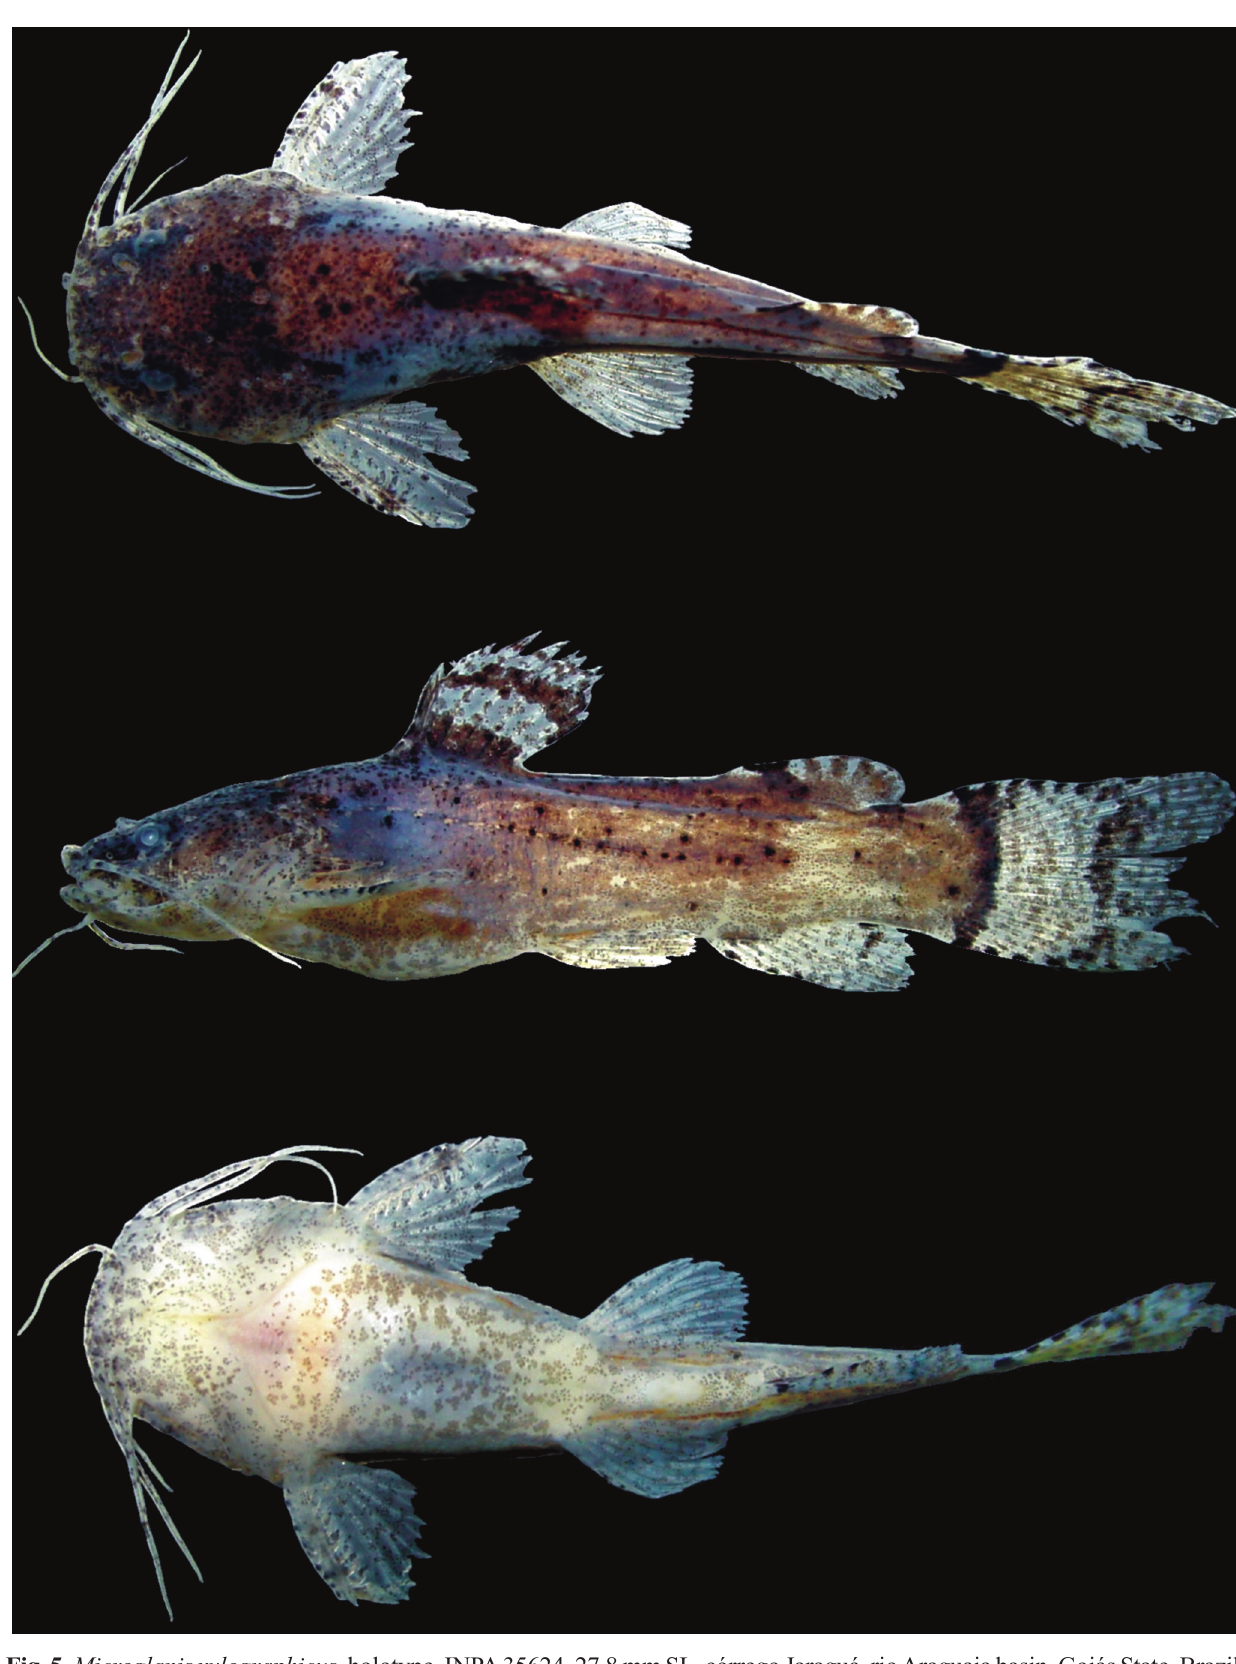
Fig. 5. Microglanis xylographicus , holotype, INPA 35624, 27.8 mm SL, córrego Jaraguá, rio Araguaia basin, Goiás State, Brazil. Dorsal, lateral and ventral